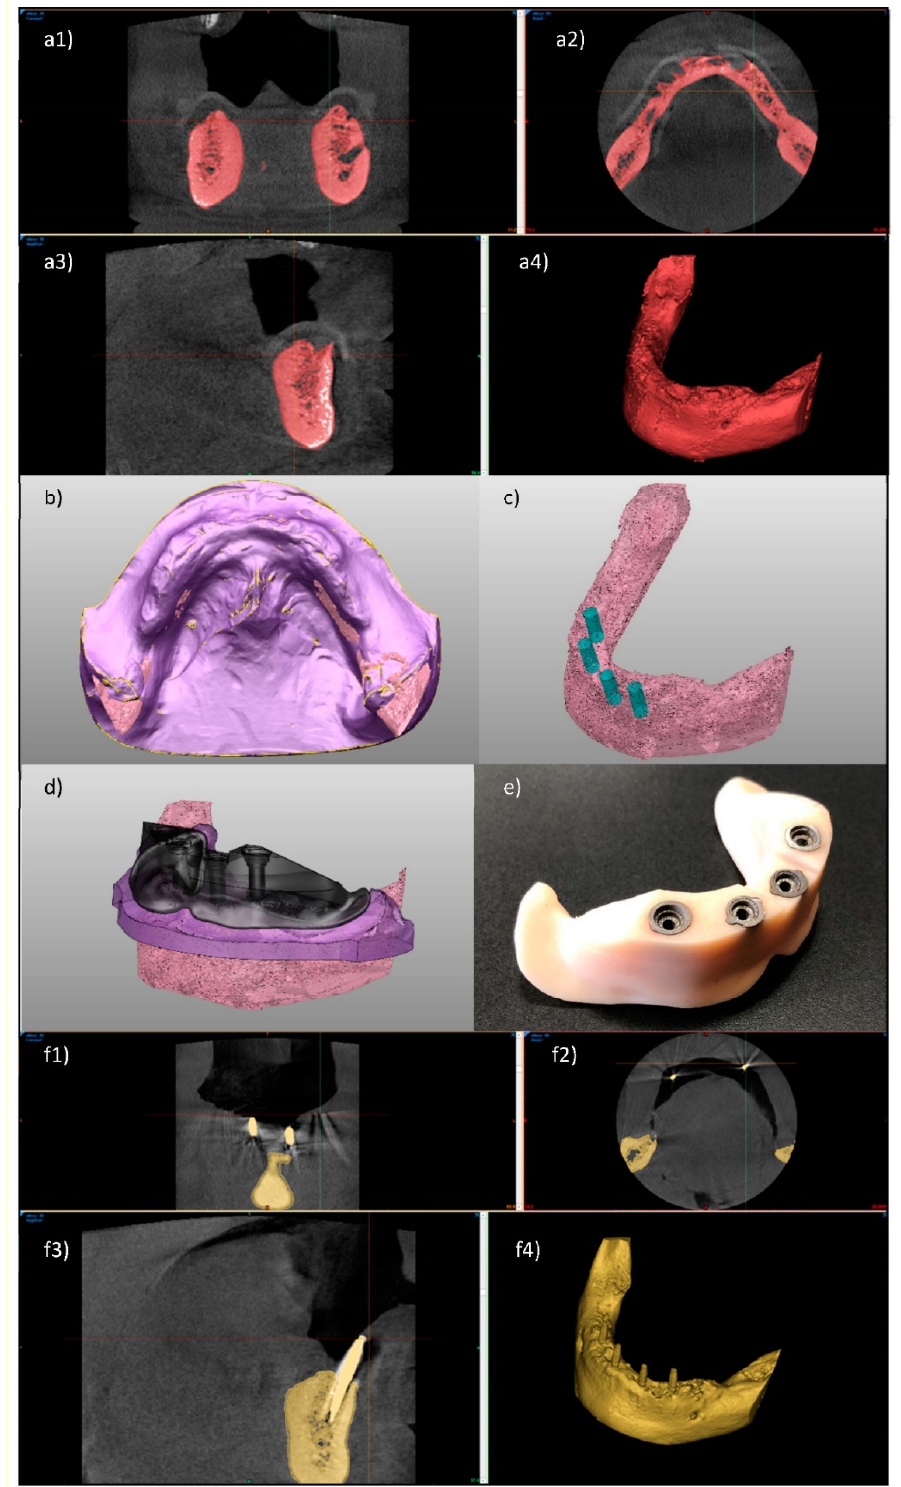
Figure 17. (On the previous page) Description of the procedure for making a template for implanting 4 implants; ( a1 – a4 ) verifying the accuracy of the model; ( b ) a scanning plate visible on the 3D tomogram pattern; ( c ) the plan the placement of implants; ( d ) the assembly model of the intraoral model and bone base model; ( e ) the surgical guide printed in SLA technology; ( f1 – f4 ) a CBCT control test with control pins.